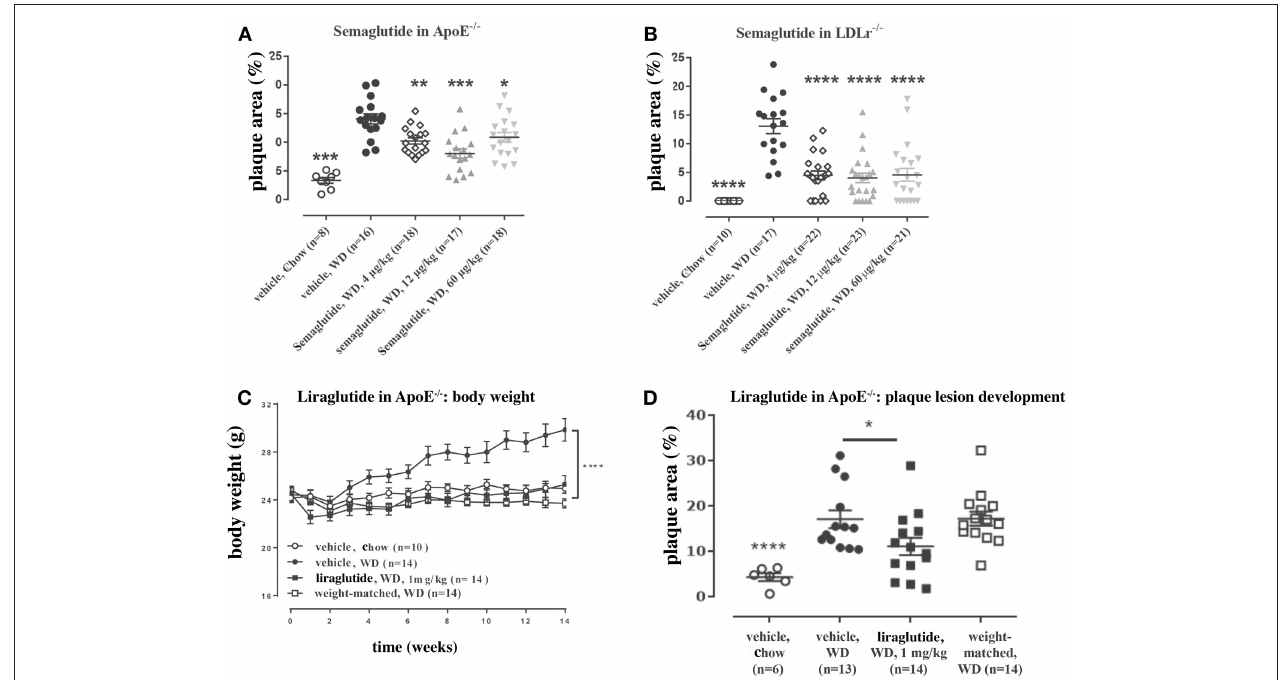
FIGURE 10 | Plaque lesion development with semaglutide and liraglutide in apolipoprotein E and low-density lipoprotein receptor knockout mice aorta, and effect on atherosclerosis. (A) Semaglutide significantly decreased WD-induced plaque lesion development at all dose levels in ApoE − / − mice: * p = 0.0266, ** p = 0.0046, **** p < 0.0001 vs. vehicle WD, and (B) LDLr − / − mice: **** p < 0.0001 vs. vehicle WD. (C) WD-induced increases in body weight were significantly lowered by liraglutide and in the weight-matched comparator: **** p < 0.0001 vs. vehicle, WD. (D) Liraglutide significantly attenuated WD-induced plaque lesion development, whereas the weight-matched comparator group did not: * p = 0.0448, **** p < 0.0001 vs. vehicle, WD; liraglutide, WD vs. weight-matched, WD, p = 0.06). ApoE, apolipoprotein E; LDLr, low-density lipoprotein receptor; WD, Western diet. Reprinted from Rakipovski et al. (111), Copyright 2018, with permission from Elsevier.